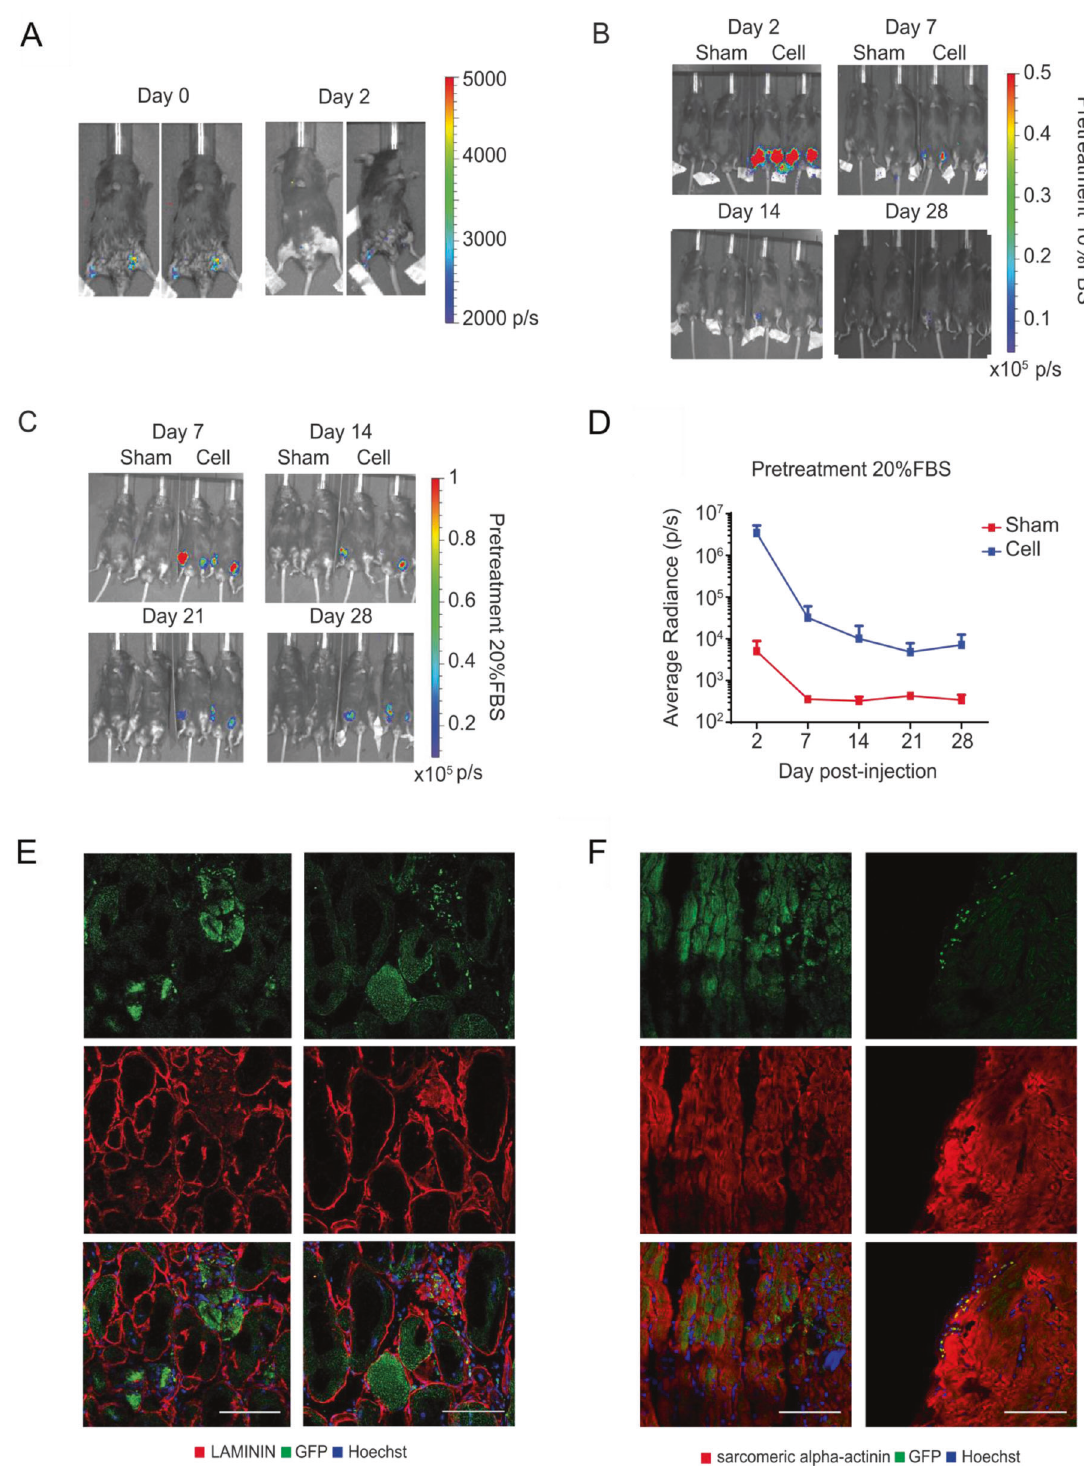
Fig. 3 Serum pre-treatment of mesodermal progenitors leads to long-term survivability and stable engraftment in the skeletal and cardiac muscles. A Representative bioluminescent images of beta-sarcoglycan-null ( Sgcb -/- ) / common gamma knockout ( Rag2 γ c -/- ) mice injected in both hind limbs with 1.5 × 10 6 mesodermal progenitors (cdMiPs). B Representative bioluminescent images of Sgcb -/- /Rag2 γ c -/- mice injected with saline (sham) or 1.5 × 10 6 cdMiPs treated with 10% serum (cell) in the hind limbs. Images were taken 2-, 7-, 14-, and 28-days post injection. C Representative bioluminescent images of Sgcb -/- /Rag2 γ c -/- mice injected with saline (sham) or 1.5 × 10 6 cdMiPs pre-exposed to 20% serum (cell) in the hind limbs. Images were taken 7-, 14-, 21-, and 28-days post injection. D Quanti fi cation of the BLI signal seen in C ( n = 3). E Immuno fl uorescent images of the GFP + cdMiPs present in the skeletal muscle 28 days after injection. F Immuno fl uorescence of the GFP + cdMiPs present in the heart, 28 days after injection. Scale bars: 100